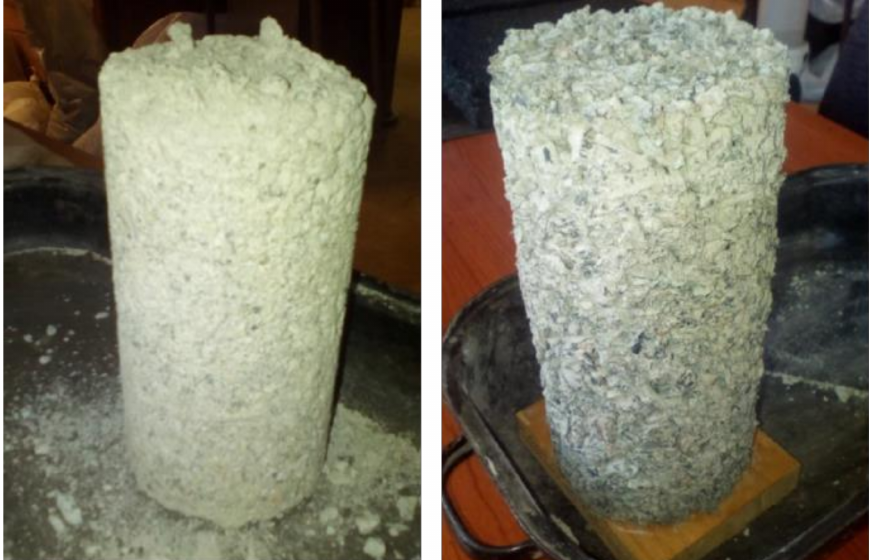
Figure 5. Specimens for CTT: GM 0/22 ( left ); GM 0/32 ( right